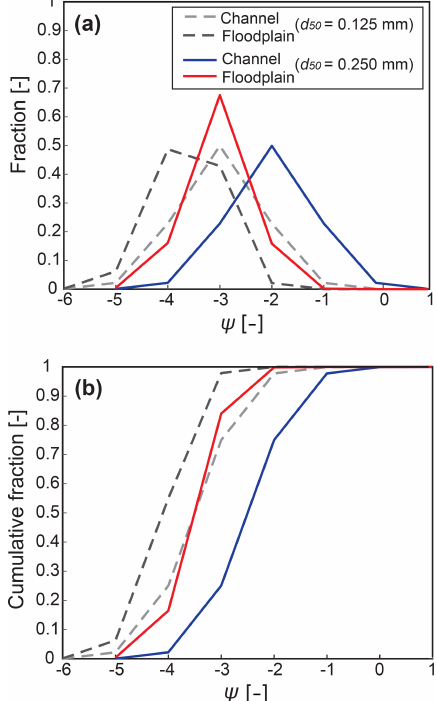
Figure 2. (a) Grain-size distribution curves and (b) cumulative grain-size distributions of suspended sediments at near bed and at channel-floodplain boundary. Dashed lines are for the chan- nel (gray) and floodplain (black) when d 50 = 0 . 125mm and solid lines are for the channel (blue) and floodplain (red) when d 50 = 0 . 250mm,